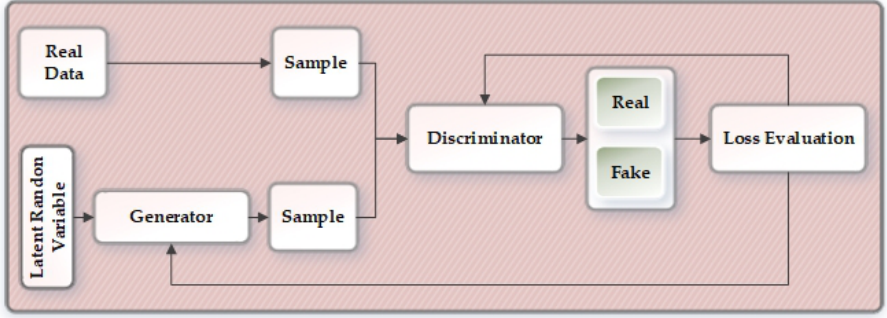
Figure 5. Overview of the generative adversarial